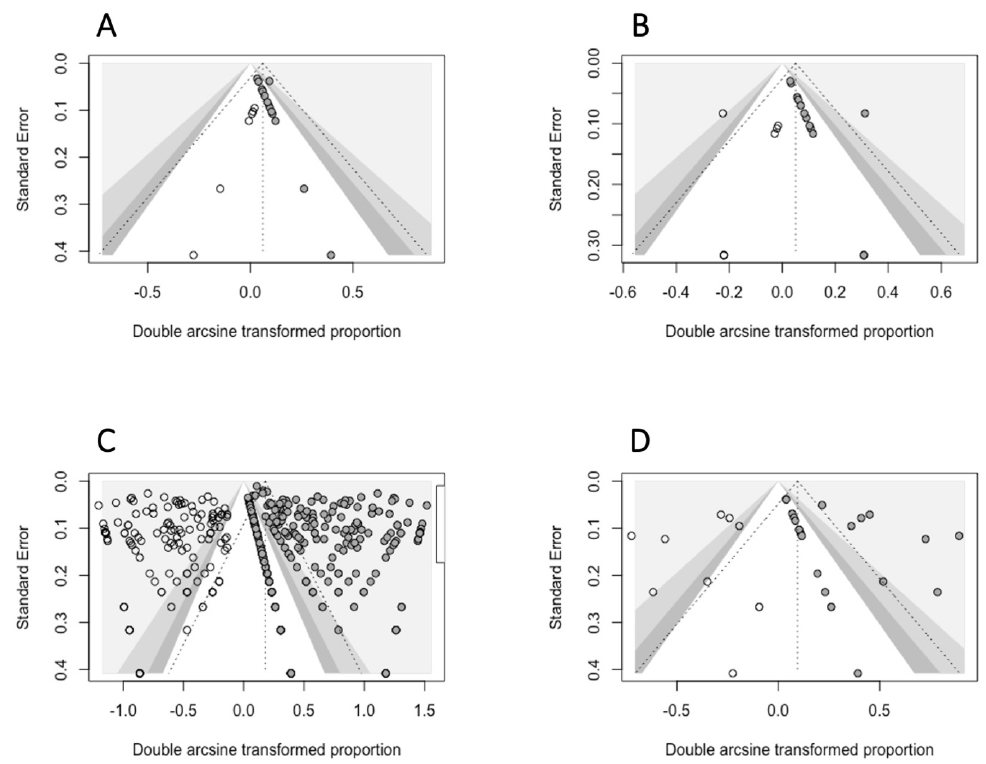
Figure 10. Contour-enhanced funnel plots of prevalence estimates that showed significant funnel plot asymmetry (Egger’s test p < 0.05). Solid-filled circles indicate the studies included in the original meta-analysis; empty circles indicate studies added by the trim-and-fill method to adjust for funnel plot asymmetry. ( A ) A. centrale ; ( B ) A. bovis ; ( C ) Rickettsia spp.; ( D ) R. aeschlimannii .